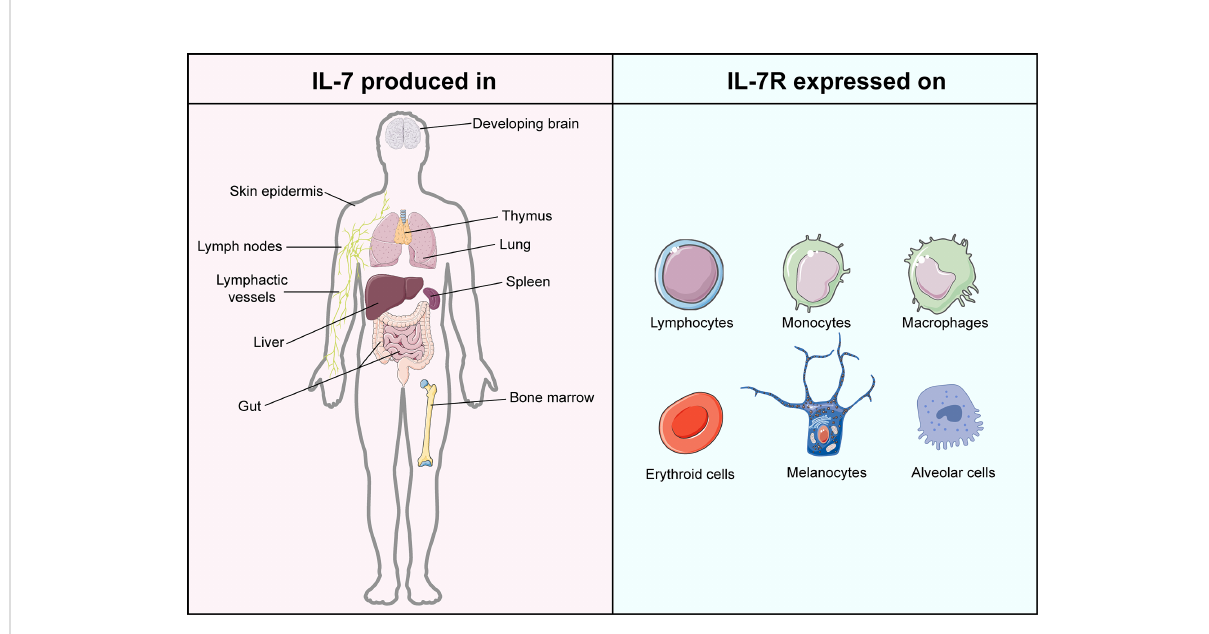
FIGURE 1 Atlas of IL-7 production and IL-7R expression. IL-7 is mainly produced in but not limited to lymphoid organs, including bone marrow, thymus, spleen, and lymphoid nodes. IL-7 is majorly generated by stromal cells but is also evidenced in epithelial cells, keratinocytes, dendritic cells, and hepatocytes. The expression of IL-7R can be found in lymphocytes, monocytes, macrophages, erythroid cells, melanocytes, and alveolar cells. This fi gure is created with BioRender.com and